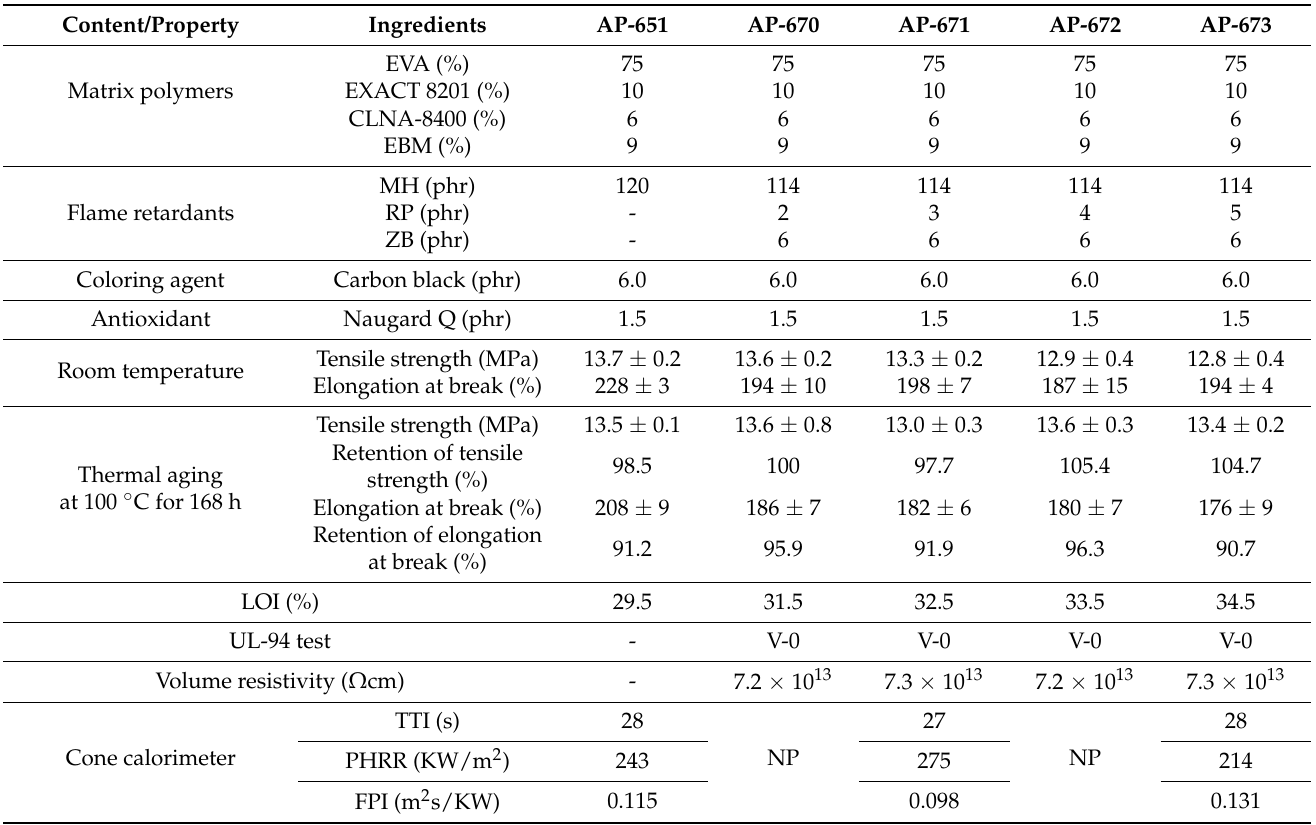
Table 2. EVA/EXACT 8201/CLNA-8400/EBM/120 phr flame-retardant (MH+ZB) formulations as a function of additional RP